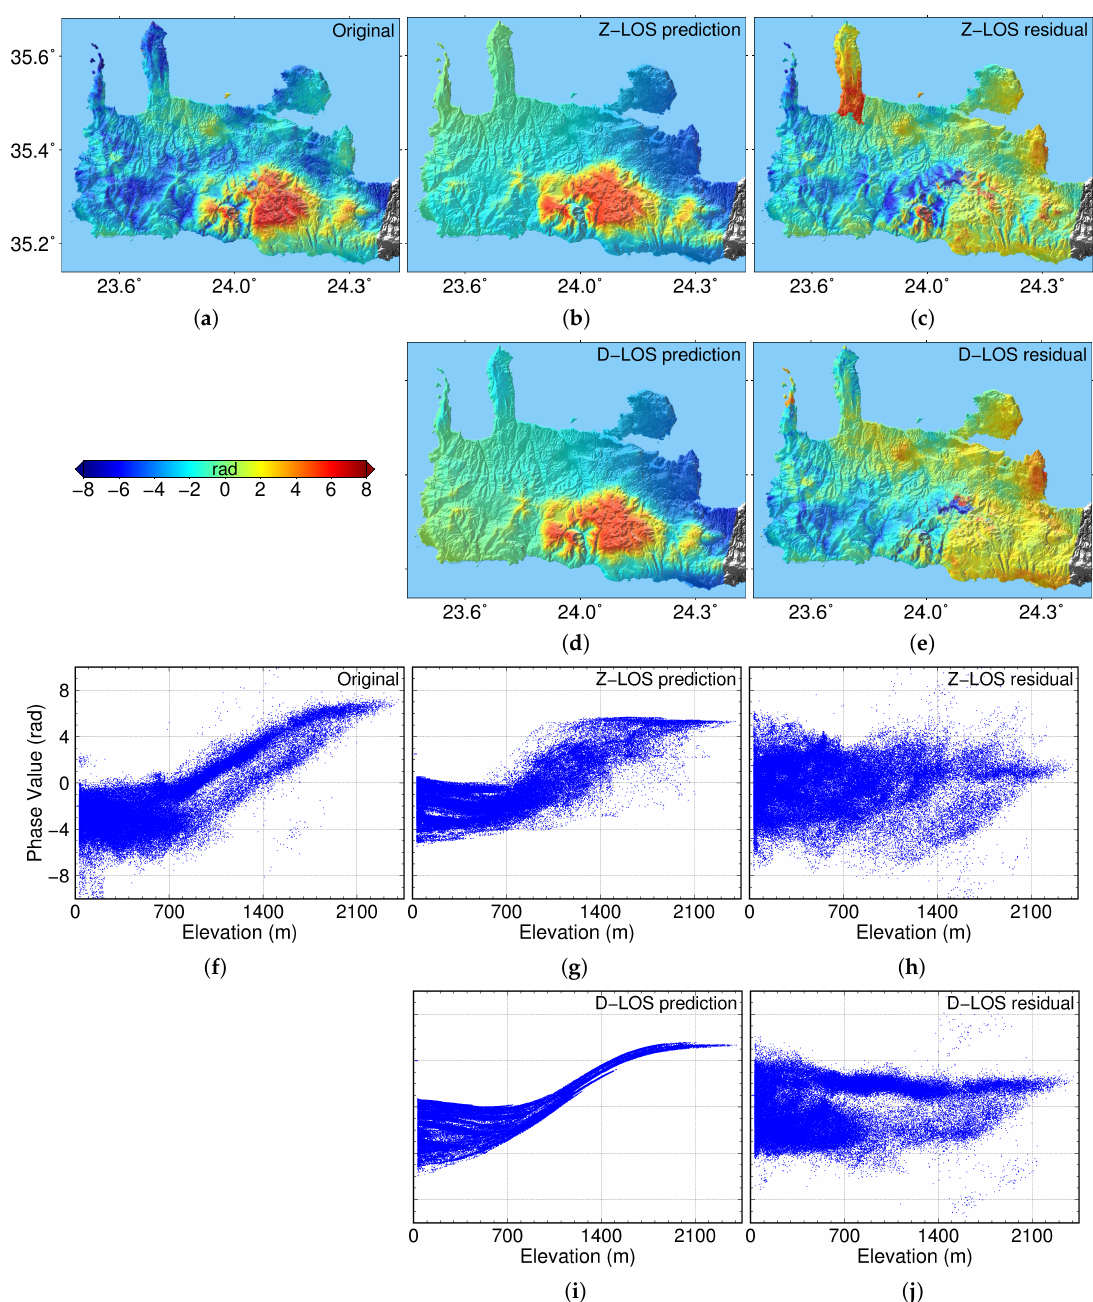
Figure 11. 20171126–20171208 (Ifg8) case study of APS compensation in Crete. ( a – e ) represent the original interferogram, Z-LOS predicted APS, residue phase after Z-LOS correction, D-LOS predicted APS, and residue phase after D-LOS correction, respectively. ( f – j ) are the phase-elevation scatters for the original phase, Z-LOS predicted APS, the residue phase after Z-LOS correction, D-LOS predicted APS, and the residue phase after D-LOS correction,